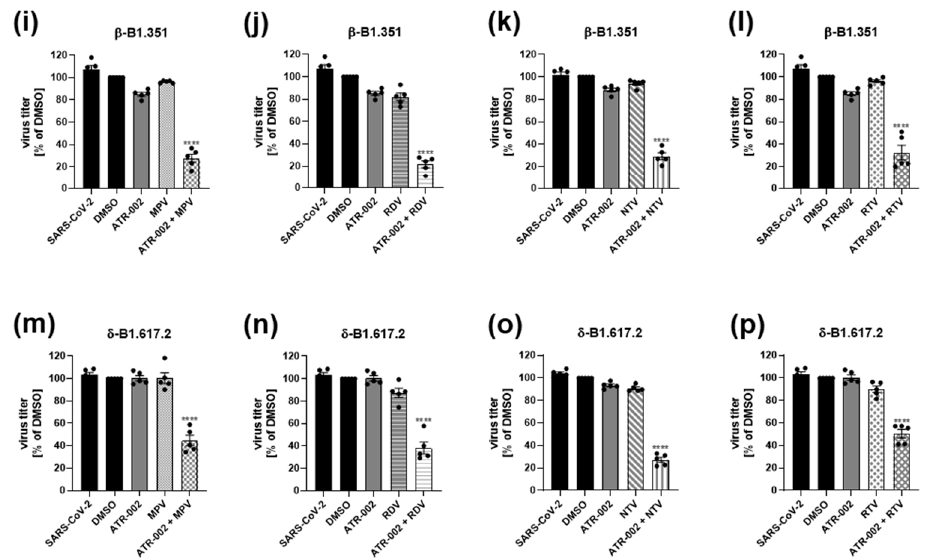
Figure 4. Synergistic effects of MPV, RDV, NTV and RTV in combination with ATR-002 on different SARS-CoV-2 VOCs in Calu-3 cells. Calu-3 cells were infected with SARS-CoV-2 (MOI: 0.01). Drug treatments were initiated 1 h.p.i. MPV (0.047 µM) ( a , e , i , m ), RDV (0.034 µM) ( b , f , j , n ), NTV (0.006 µM) ( c , g , k , o ) or RTV (0.057 µM) ( d , h , l , p ) were combined with ATR-002 (12.05 µM). Untreated (SARS-CoV-2), DMSO-treated and single-treated (drug + DMSO) cells served as controls. Viral titers were analyzed 48 h.p.i. and are depicted in % of DMSO. DMSO was arbitrarily set to 100%. Shown are means ± SEM of five independent experiments, each performed in triplicates. Significance was calculated using an unpaired t -test for each inhibitor individually, comparing the single-treated (MPV, RDV, NTV, RTV) vs. the double-treated results (**** p ≤ 0.0001) (see also Figure S8).